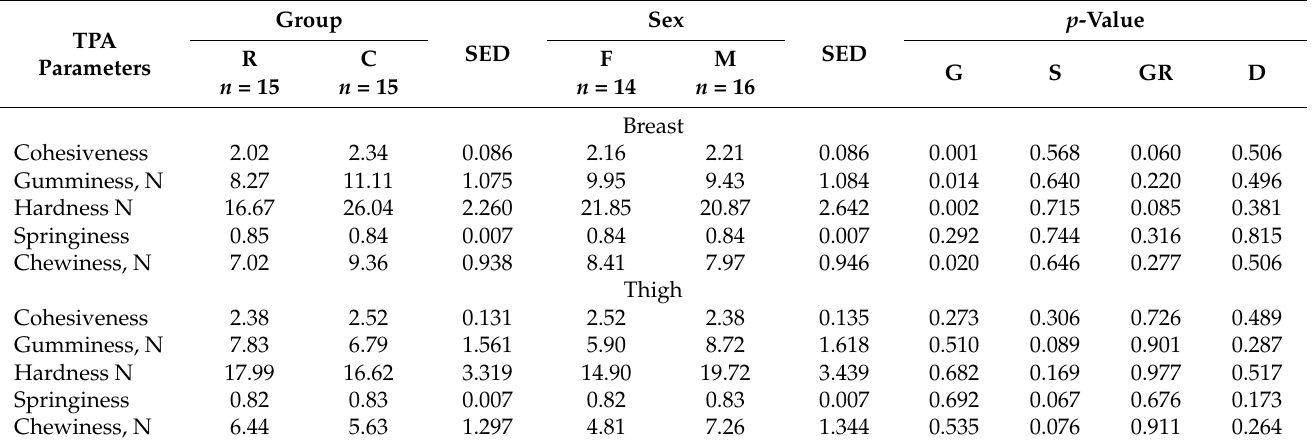
Table 6. Effects of camelina and rapeseed diet and sex on goose meat texture evaluated by texture profile